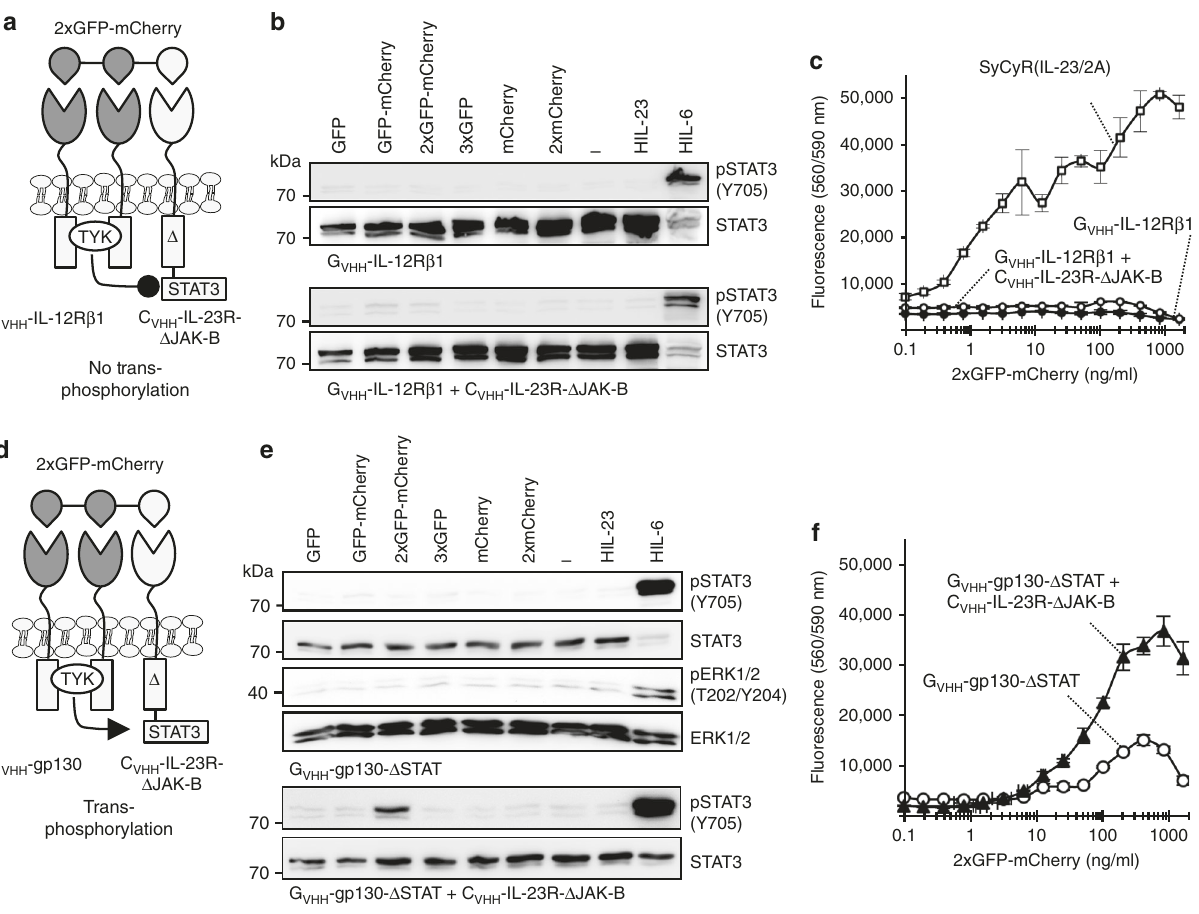
Fig. 8 Engineered heterotrimeric SyCyRs based on G VHH -IL-12R β 1 and G VHH -gp130 homodimerization fail in STAT3 trans-phosphorylation. a Schematic illustration of IL-12R β 1-SyCyRs simulating STAT3 trans-phosphorylation using 2xGFP-mCherry. G VHH -IL-12R β 1: GFP-nanobody fused to 15 aa of ECD, TMD, and ICD of IL-12R β 1, lacking any STAT-binding motifs. C VHH -IL-23R- Δ JAK-B variant: mCherry-nanobody fused to 16 aa of ECD, the TMD and ICD of the IL- 23R lacking JAK activation site ( Δ JAK-B). b STAT3 activation in indicated Ba/F3-G VHH -IL-12R β 1 cells lines were stimulated with 16% CHO-K1 conditioned supernatant containing mCherry, 2xmCherry or conditioned supernatant containing 400 ng/ml of the other indicated ligands for 60 min or with HIL-23 (10 ng/ml) for 60 min and HIL-6 (10 ng/ml) for 15 min. Total proteins (25 µ g/lane for HIL-6 and 50 µ g/lane for other ligands) were analyzed for phospho- STAT3 and STAT3. Western blot data show one representative experiment out of three. c Proliferation of indicated Ba/F3-SyCyR(IL-23/2A) and Ba/F3- G VHH -IL-12R β 1 cell lines were cultured in the presence of 2xGFP-mCherry (0.1 – 1600 ng/ml). One representative experiment out of two is shown. Results are mean ± s.d. of three replicates. d Schematic illustration of gp130-SyCyRs simulating STAT3 trans-phosphorylation with 2xGFP-mCherry. G VHH -gp130- Δ STAT: GFP-nanobody fused to 13 aa of the ECD, the TMD and ICD of gp130 lacking the STAT-binding motifs. C Δ JAK-B: mCherry-nanobody VHH -IL-23R- fused to 16 aa of the ECD, the TMD and ICD of the IL-23R lacking JAK activation site. e STAT3 and ERK1/2 activation in indicated Ba/F3-G VHH -gp130- Δ STAT cell lines were stimulated with 8% CHO-K1 conditioned supernatant containing mCherry, 2xmCherry or conditioned supernatant containing 200 ng/ml of the other indicated ligands for 60 min or HIL-23 (10 ng/ml) for 60 min or HIL-6 (10 ng/ml) for 15 min. Equal amounts of total protein (for STAT3 analysis 25 µ g/lane for HIL-6 and 50 μ g/lane for other ligands. For ERK1/2 analysis 12.5 µ g/lane for HIL-6 and 75 µ g/lane for other ligands) were analyzed for phospho-STAT3/ERK1/2 and STAT3/ERK1/2. Western blot data show one representative experiment out of two. f Proliferation of indicated Ba/F3- G VHH -gp130- Δ STAT cells lines were cultured in the presence of 2xGFP-mCherry (0.1 – 1600 ng/ml). One representative experiment out of four is shown. Results are mean ± s.d. of three